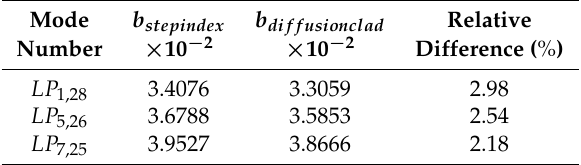
Table 5. Comparison between the propagation constant estimates for both the step index and diffusion modeled clad